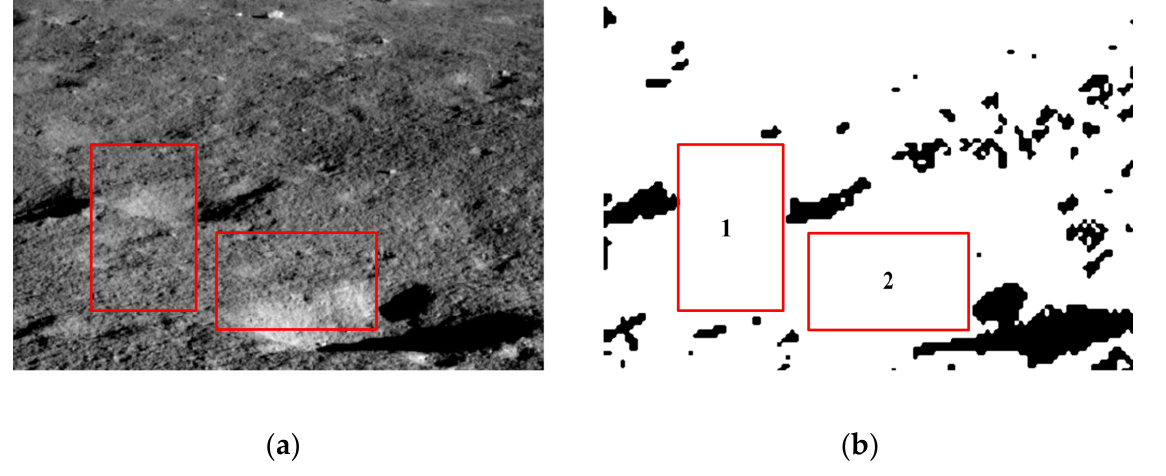
Figure 14. ( a ) Two sub-regions of the image, ( b ) Shadow map. Figure 15 shows enlarged views of the area ROI 1 outlined in Figure 14b, the area includes lunar regolith and the rim of a small crater. SGM results and results of three methods have been normalised. As Figure 15b shows, the heights change continuously in a small range, and the rim of the small crater is recovered correctly. The height distribution of PPS result in Figure 15c is similar with that of SGM result, where the upper part is higher than the lower part. Figure 15d,e show SGM and PPS result of ROI 1 with corresponding hillshade map. The rims of three small craters in Figure 15e are clear, and subtle terrain details are displayed. As the boulders are too small, they cannot be recognised in Figure 15d,e. Figure 15f,g represent PSPP and PSOP results. As PSPP and PSOP do not include the rotation matrix, the reconstructed results are inconsistent with the SGM result. The height distributions are similar where the left part is higher than the right part. The elevation axis of Yutu-2 points up, the origin of elevation axis located at the centre of rover body chassis. Figure 15h shows the profile of the boulder marked by the white circle in Figure 15a. Figure 16 shows SGM and PPS results of the profile along the white line in Figure 15a, the left y -axis is the normalized height, the right y -axis represents the real height. According to the SGM result, height range of the test area is about 0.18 m. Most of the normalised height of PPS result is larger than that of SGM result, the trend of the curves is